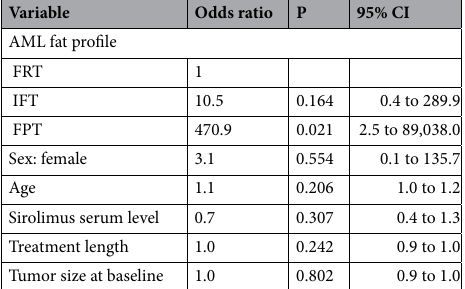
Table 3. Firth’s logistic regression for an at-least-50% tumor volume reduction. CI confidence interval, FPT fat-poor tumor, FRT fat-rich tumor, IFT intermediated-fat